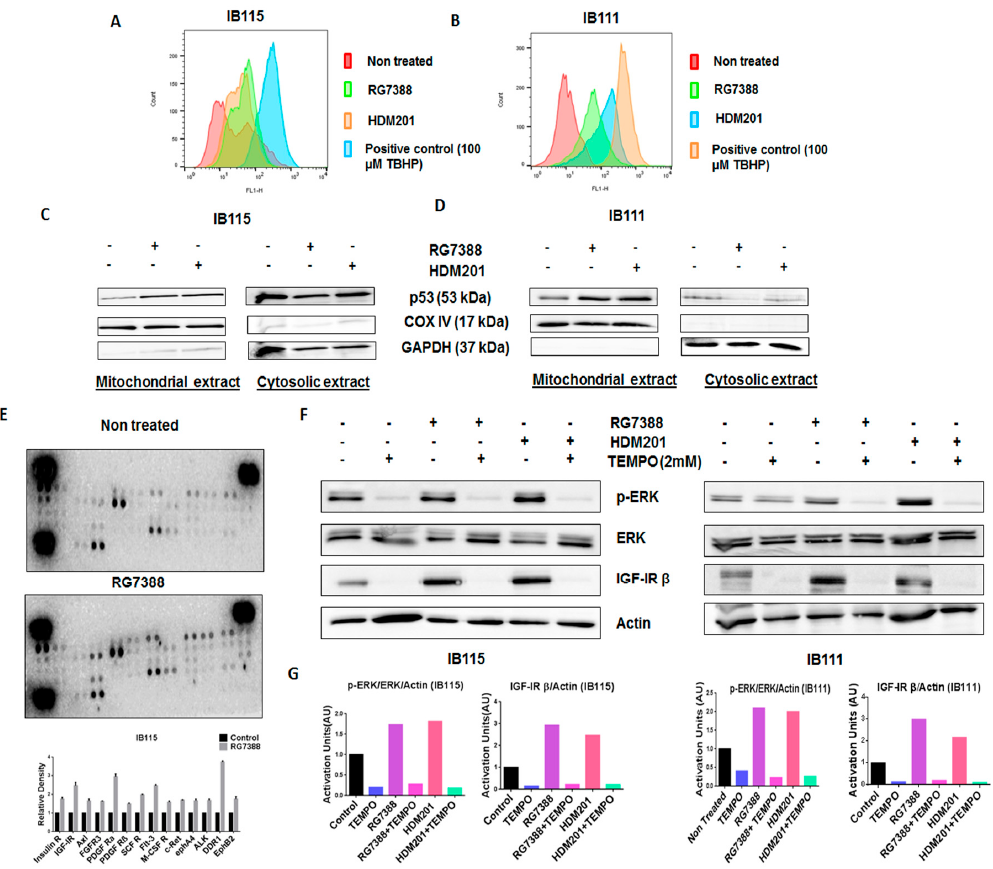
Figure 5. The mitochondrial translocation of p53 and p53-induced production of reactive oxygen species (ROS) upon treatment with MDM2 antagonists led to the phosphorylation of ERK in DDLPS cells through the activation of receptor tyrosine kinases (RTKs). ( A,B ) MDM2 antagonists RG7388 and HDM201 induced generation of ROS in IB115 and IB111 cells, which were stained with DCFDA dye for 30 min at 37 °C and treated for 4 h, and the intensities of intracellular DCF were analyzed by flow cytometer. ( C,D ) MDM2 antagonist (RG7388 and HDM201)-induced generation of ROS is dependent on the mitochondrial translocation of p53. IB115 ( C ) and IB111 ( D ) were treated with RG7388 and HDM201 for 24 h. After 24 h, the cells were subjected to subcellular fractionation into cytosolic and mitochondrial fractions for immunoblot analysis of p53. COX IV and GAPDH were used as mitochondrial and cytosolic loading controls, respectively. ( E ) RG7388 treatment on IB115 cells resulted in an increased expression of Insulin R and PDGFR family RTKs through Phospho-RTK array profiling. Shown is a representative example of phosphoprotein array of control and RG7388-treated IB115 using the Proteome Profiler Human Phospho-RTK Array Kit. This platform allowed simultaneous screening of 49 di ff erent RTKs. ( F ) E ff ect of TEMPO on RG7388- and HDM201-induced phosphorylation of ERK. DDLPS IB115 and IB111 cells were treated with 2 mM TEMPO either alone or in combination with RG7388 or HDM201 for 24 h. Cells were subjected to immunoblot analysis against p-ERK, ERK, and IGF-1R β . Actin was used as the loading control. ( G ) Quantification of blots of IB115 and IB111 on treatment with TEMPO, RG7388, and HDM201 alone or in